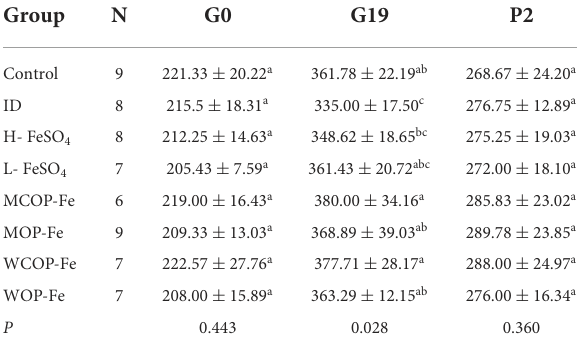
TABLE 2 Amino acid composition of food-derived bioactive oligopeptide iron complexes.